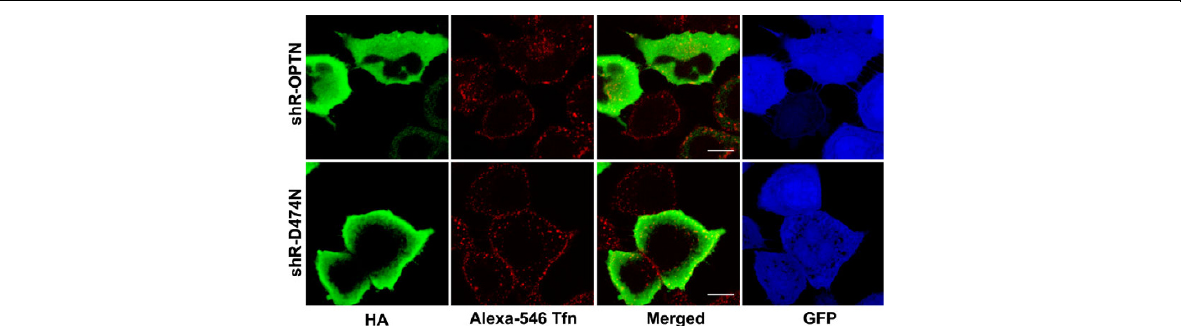
Figure 6 The UBD is required for trafficking of transferrin . HeLa cells infected with adenoviruses expressing shRNA (Ad-shOPTN2) were transfected with shRNA resistant wild type or D474N mutant optineurin. Cells were incubated with Alexa 546-Tfn for 15 min, fixed, stained for optineurin and examined by confocal